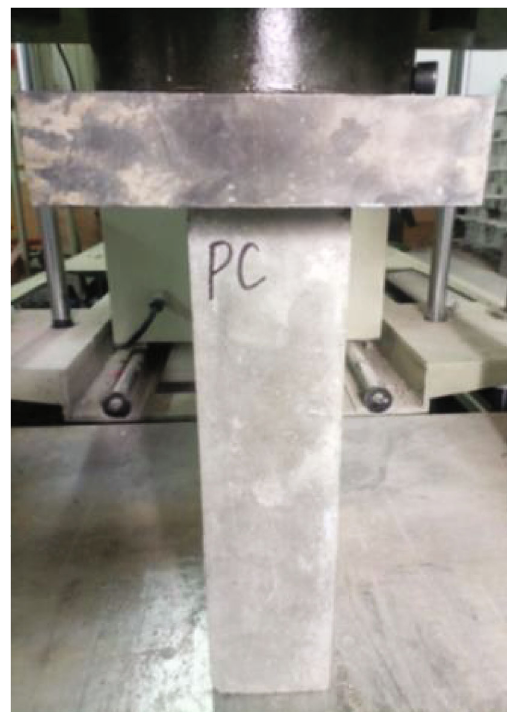
Figure 15: Uniaxial compression